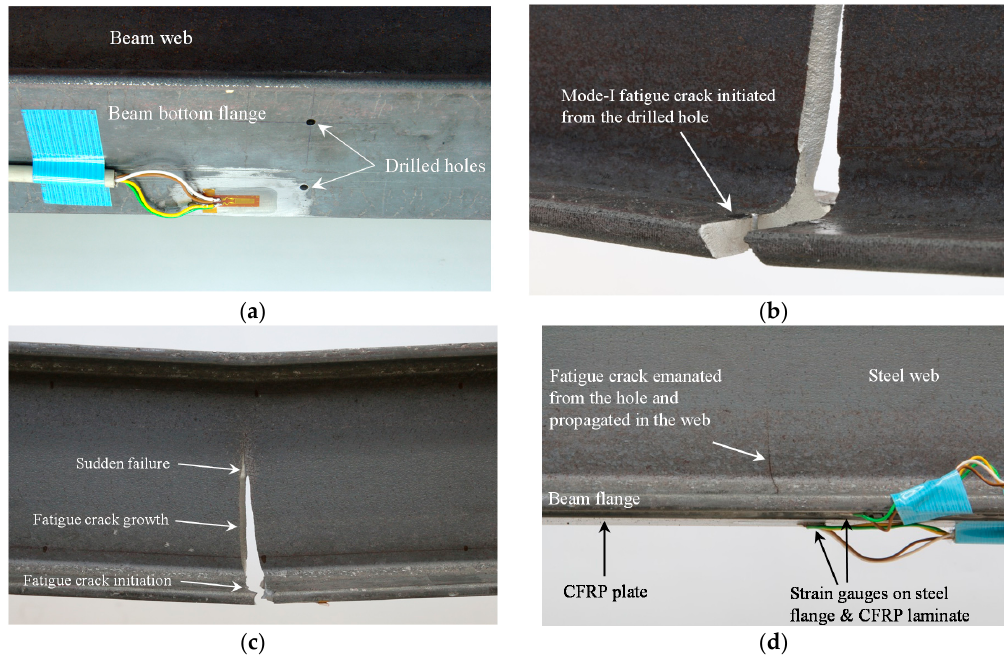
Figure 13. ( a ) Holes drilled in the beam bottom flange; ( b ) crack emanating from stress concentration location; ( c ) different stages of fracture failures: crack initiation, crack propagation and a sudden fracture failure; ( d ) fatigue crack initiated from the hole of the retrofitted specimen and propagated into the steel web.